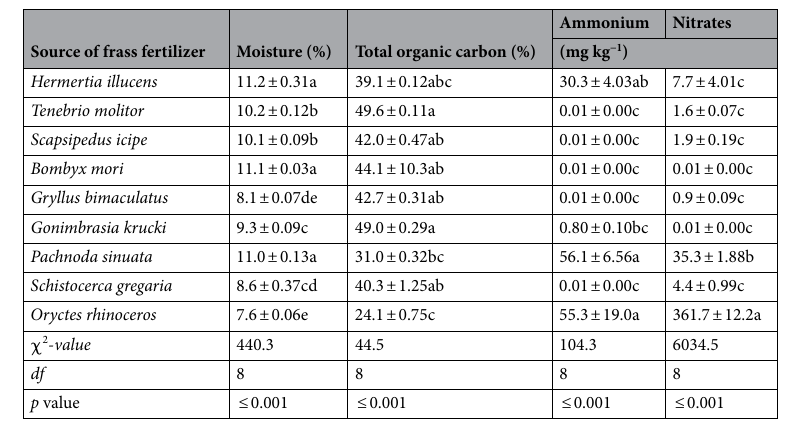
Table 1. Selected characteristics of frass fertilizer produced by different edible insect species. In the same column, means (± standard error) followed by the same letters are not significantly different at p ≤ 0.05, n =